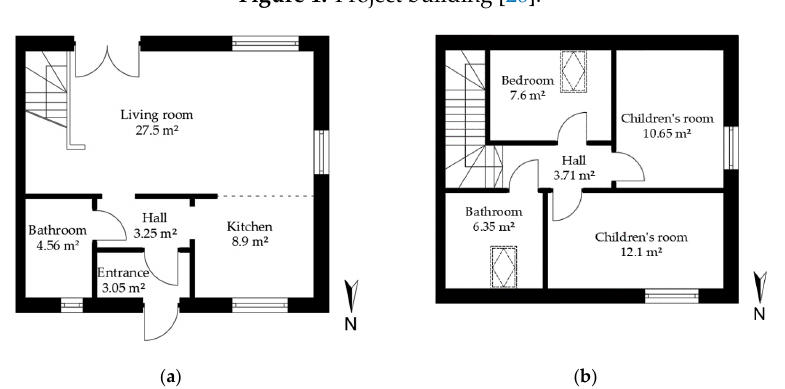
Figure 2. Plan of ( a ) ground floor; ( b ) usable floor.